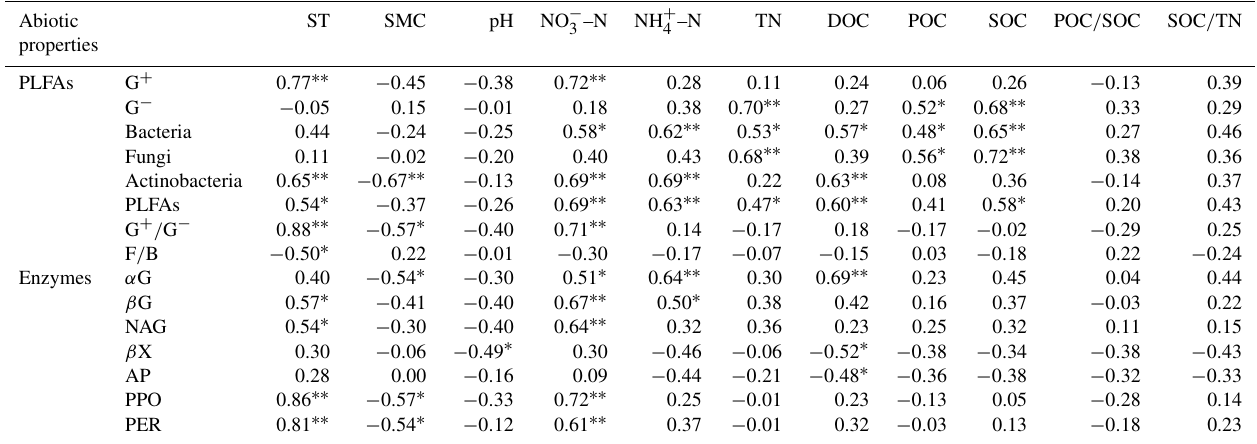
Table A3. Pearson correlation coefficients between soil abiotic properties, PLFA contents, and potential enzyme activities.